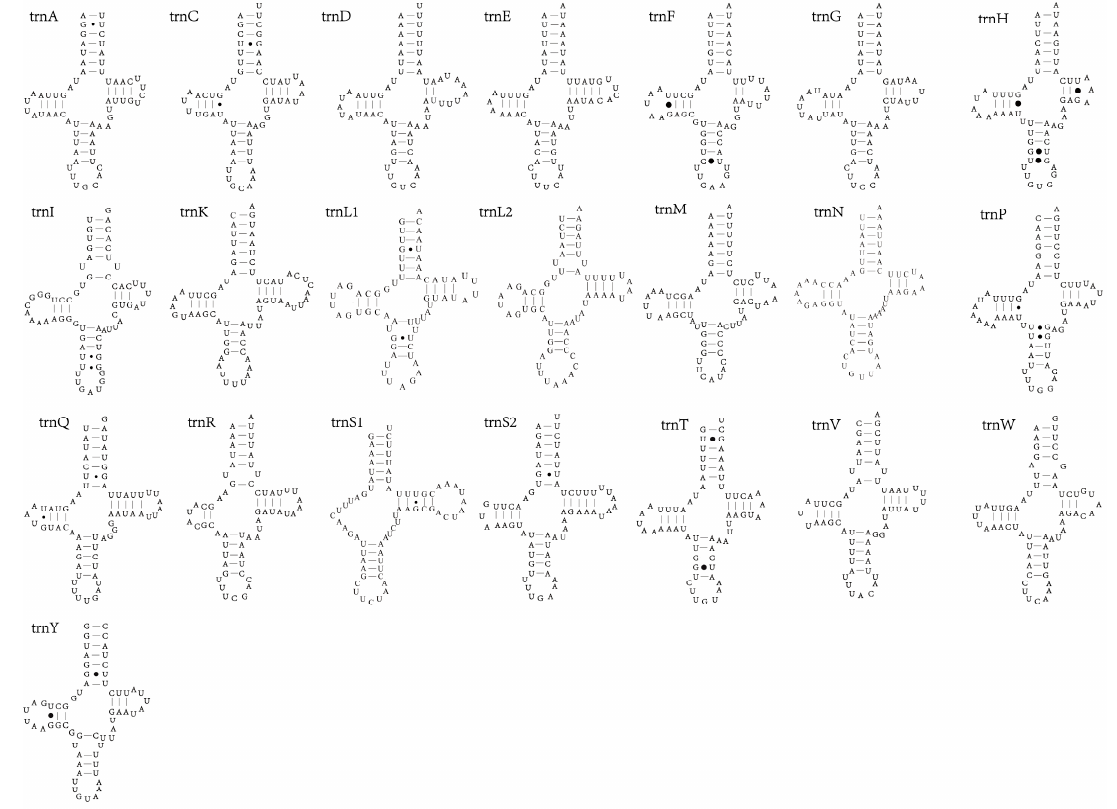
Figure 3. Secondary structure of 22 tRNAs identified in the mitogenome of D. approximata